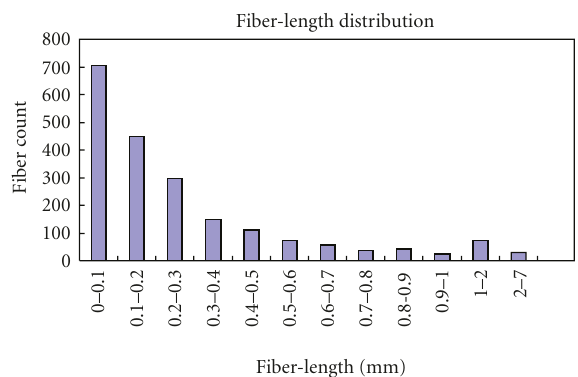
Figure 15: Resulting fiber-length distribution of dataset two. As expected from the visual inspection, many short fibers are